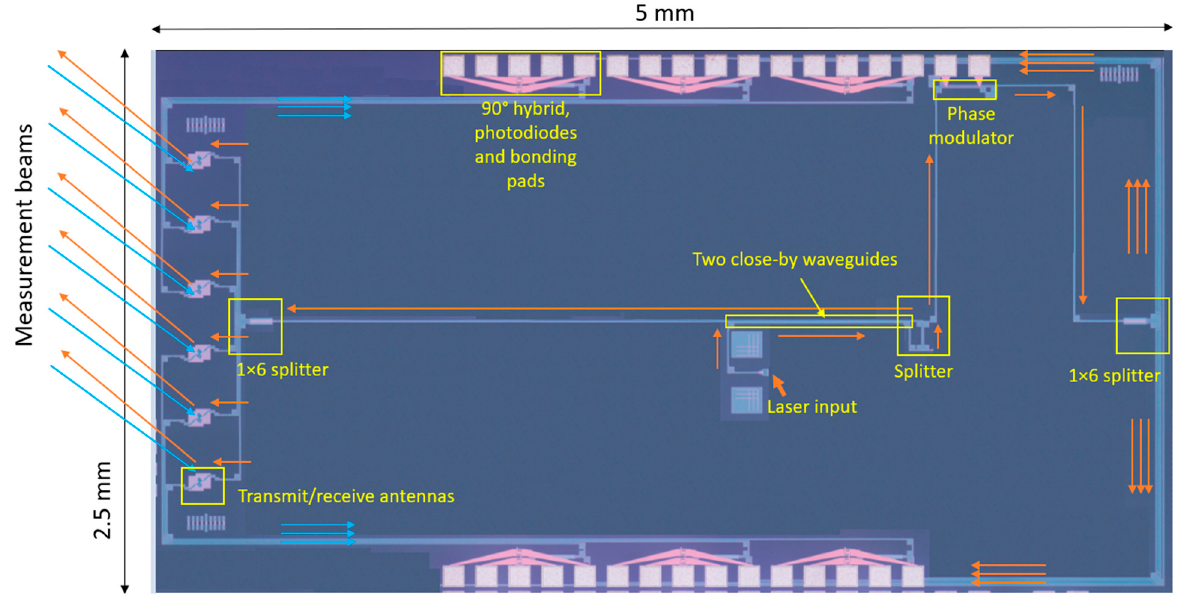
Figure 7. The microscopic image of a six-beam homodyne LDV.